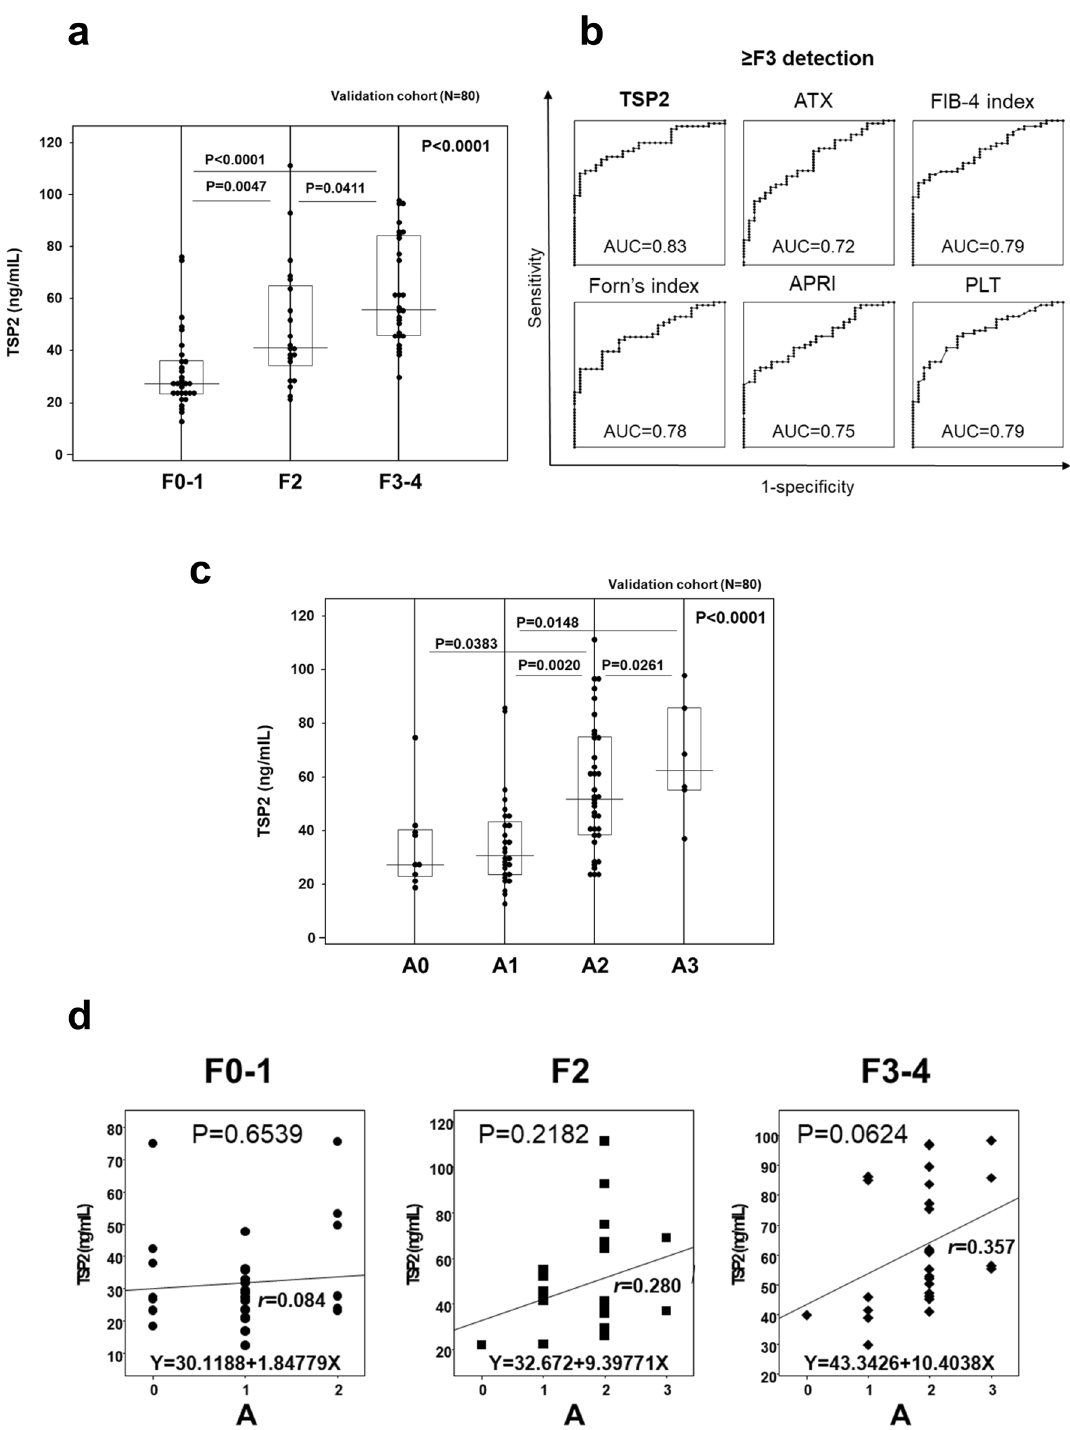
Figure 2. Validation of correlation between serum TSP2 levels and fibrosis stage/activity grade in HCV- infected patients. ( a ) Correlation of serum TSP2 levels and fibrosis stage. ( b ) AUC values for estimating severe fibrosis stage (≥ F3). ( c ) Correlation of serum TSP2 levels and activity grade. ( d ) Correlation of serum TSP2 levels and activity grade at different fibrosis stages. Data were obtained from 80 cases in the validation cohort. A activity grade, APRI aspartate aminotransferase to platelet ratio index, ATX autotaxin, AUC area under the receiver operating characteristic curve, F fibrosis stage, FIB-4 index fibrosis-4 index, PLT platelet count, TSP2 thrombospondin